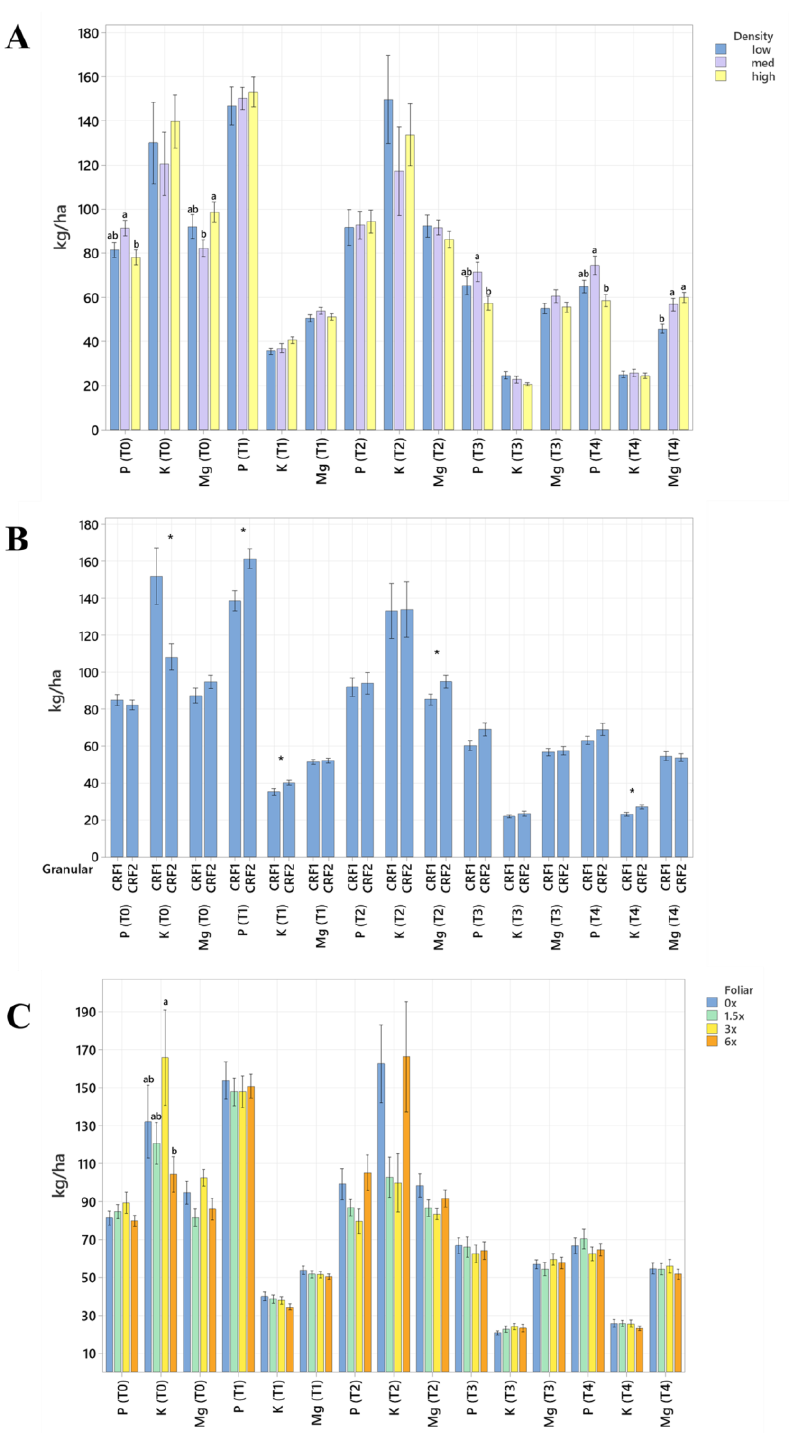
Figure 1. Soil macronutrient concentrations of ‘Ray Ruby’ grapefruit grafted on ‘Kuharske’ citrange planted in flatwood soils located in Fort Pierce, FL, USA, in response to ( A ) planting density, ( B ) ground-applied fertilizer and ( C ) foliar fertilizer treatments during September 2020 (T0), January 2021 (T1), May 2021 (T2), September 2021 (T3) and January 2022 (T4). Bars are ± standard deviation of the mean. Treatments with * and different letters were considered to be significantly different ( p < 0.05).